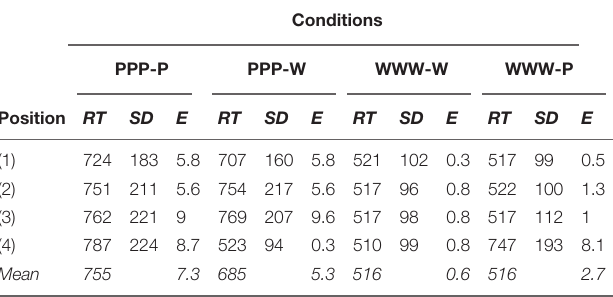
TABLE 2 | Mean naming latencies (RT in ms), standard deviations (SD in ms) and percentage of error rates (E) by Ordinal Position Within-Category and